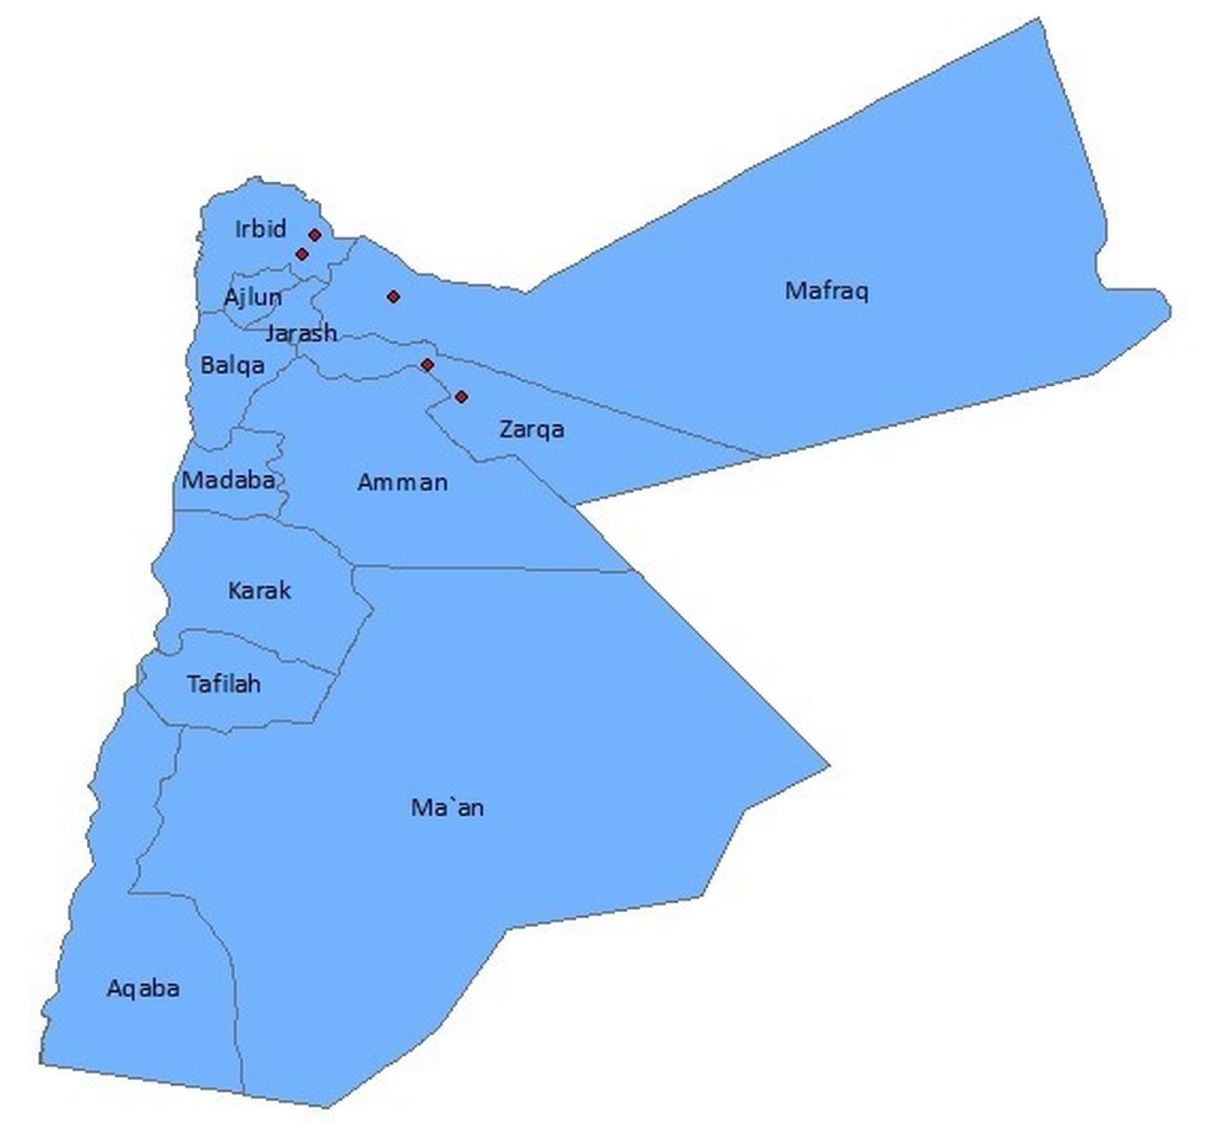
Fig 1. Map of Jordan’s Governorates and locations of Syrian refugee camps (red